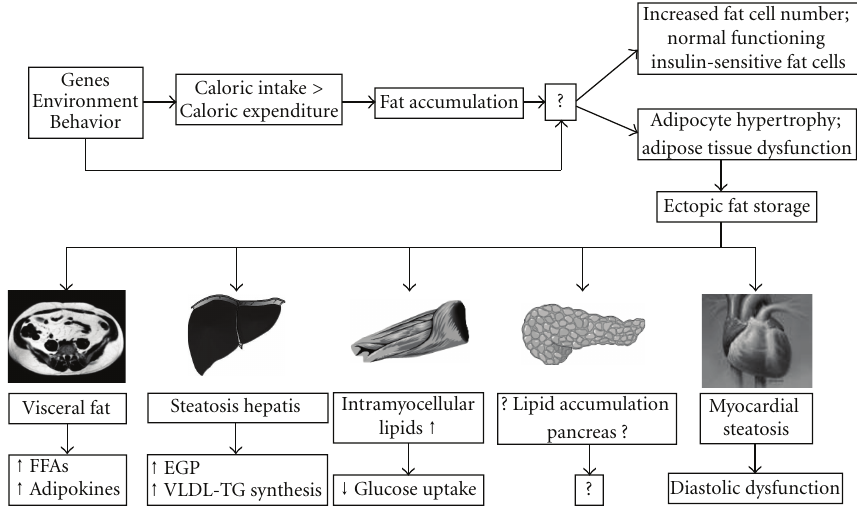
Figure 1: Ectopic fat depositions. Gene-environment interactions might be involved both in increased energy intake and decreased physical activity as well as in the response of adipose tissue to the ensuing increased energy balanced. Predisposed subjects will elicit a pathophysiologic response leading to adipocyte hypertrophy. This will lead to an inflammatory response that ultimately leads to ectopic fat deposition. The consequences of ectopic fat are organ specific as depicted in this figure. The e ff ect of ectopic fat on the cellular level is di ff erent and depicted in Figure 2. FFAs: free fatty acids; EGP: endogenous glucose production; VLDL-TG: very low-density